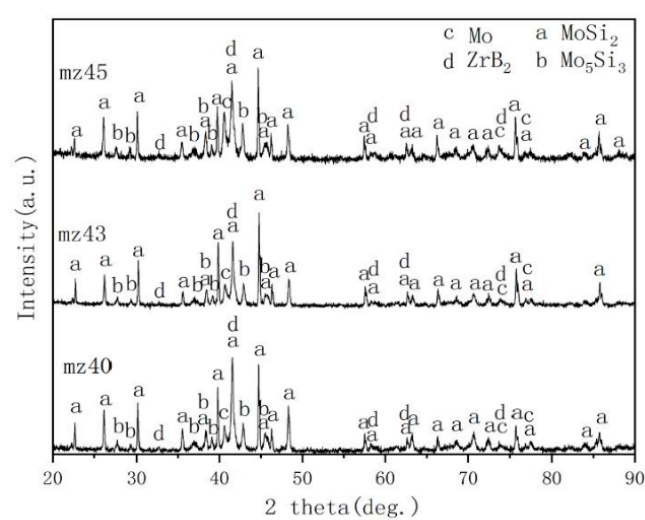
Figure 1. XRD patterns of MoSi 2 -ZrB 2 coatings.